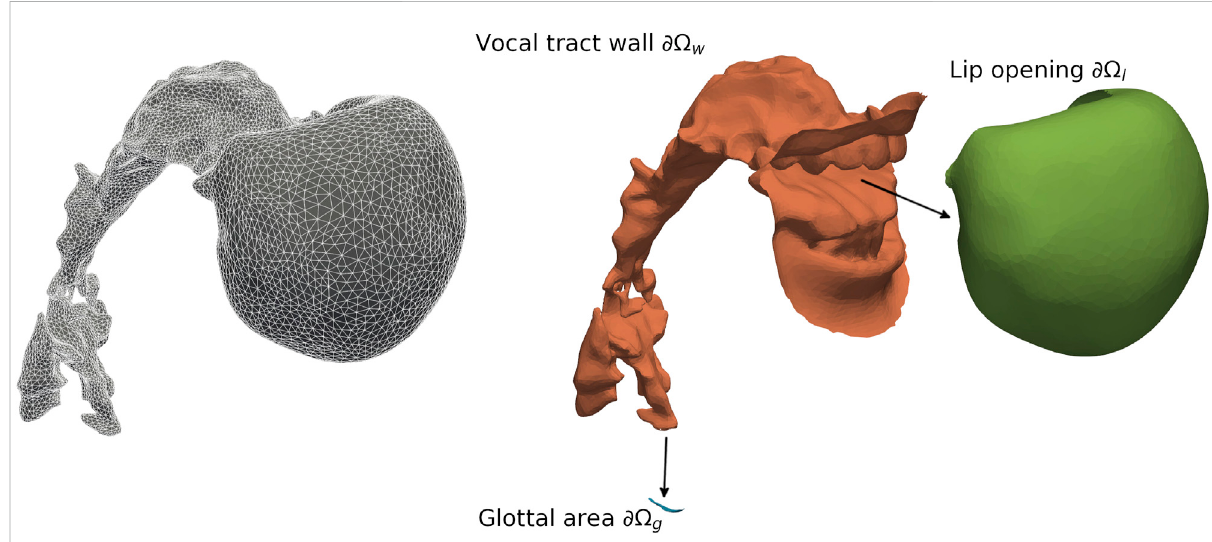
FIGURE 3 Mesh of the Finite-Element-Model (domain Ω , left in gray) and exploded view (right) to depict the patches for the lip opening ( z Ω l , green), the vocal tract wall ( z Ω w , orange), and the glottal area ( z Ω g , blue) for Belting /a ː / (A X